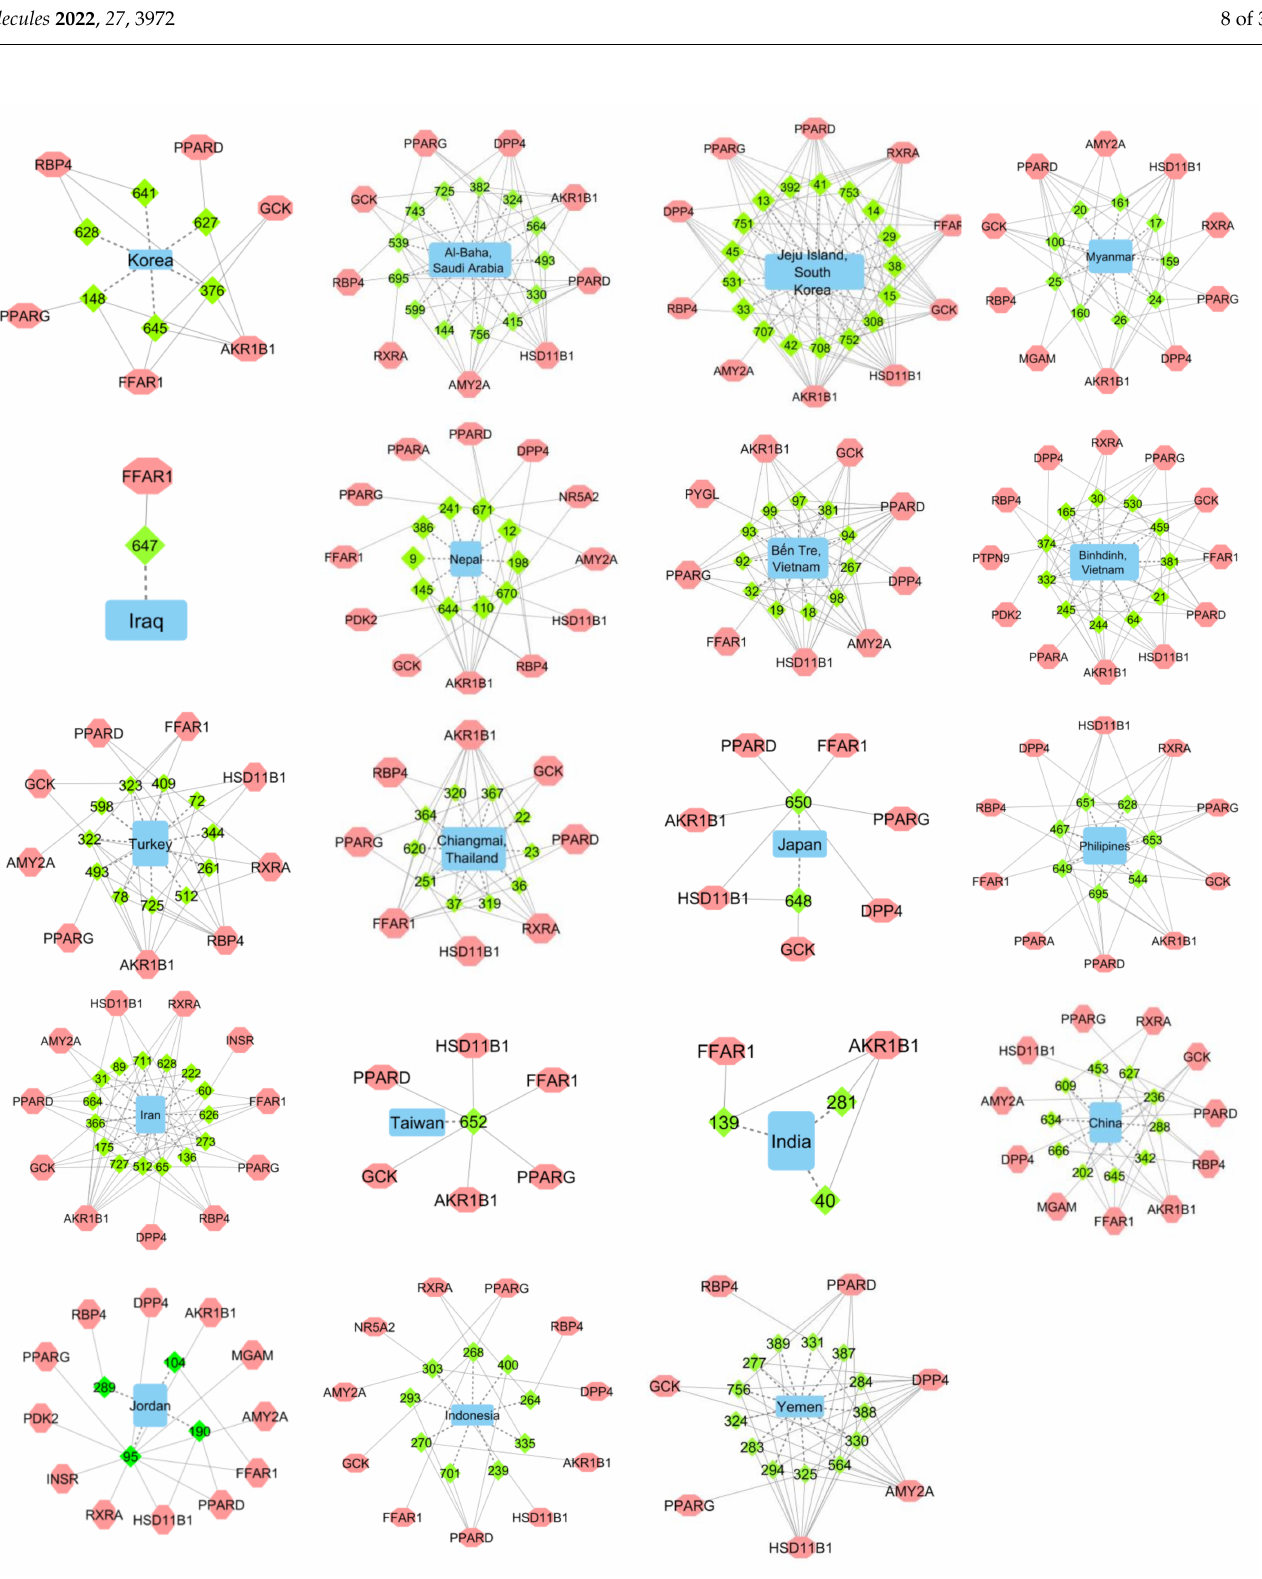
Figure 1. Nineteen Asian countries identified as propolis origins that produce propolis with novel potential anti-T2DM compounds. Potential compounds of propolis are represented by the number codes that are denoted with green diamond shapes (Table S2). Predicted T2DM targets are denoted with pink octagon shapes. The potential compounds have no previous literature on their antidiabetic potential. Dashed edges represent the edges connecting the propolis origin with their novel anti- T2DM compounds; solid edges represent the edge connecting the novel compounds with their predicted T2DM